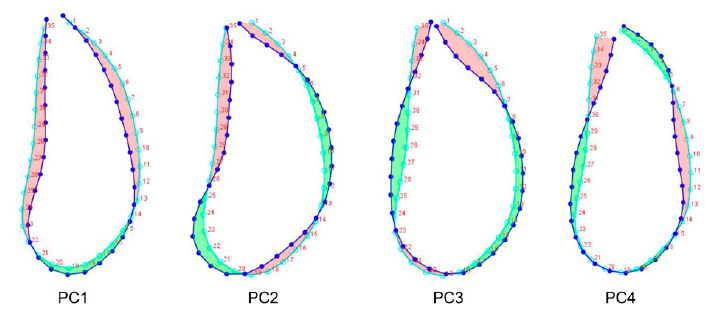
Figure 3. Principal components of the cross-sections of the mandibular interforaminal region. Light blue line: Procrustes fit, blue line: PCs. Red area: atrophy; Green area: protrusion. A parallel line to point 11 was drawn to divide the cross section into a suprabasal and basal zone.